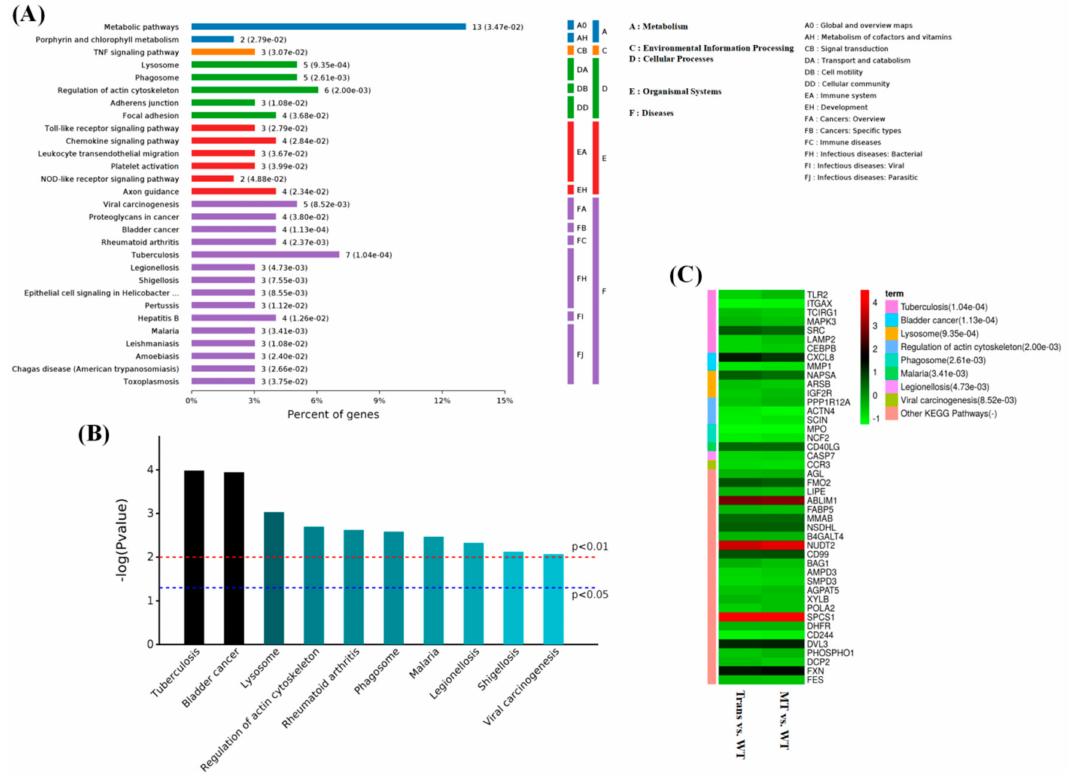
Figure 7. Enriched KEGG pathway of 119 differential proteins. ( A ) Classes of enriched KEGG pathway; ( B ) distributions of enriched KEGG pathway (top 10); ( C ) differential proteins in KEGG pathway: Red: Upregulation; green: Downregulation (high-melatonin-level goats vs wild-type (WT) goats).